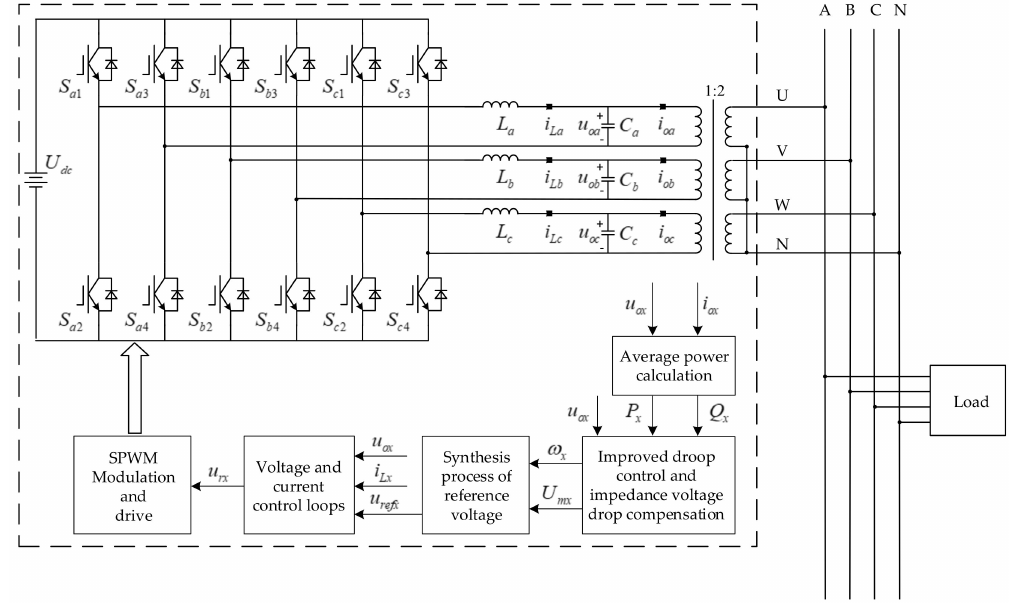
Figure 5. Main circuit and the control scheme.